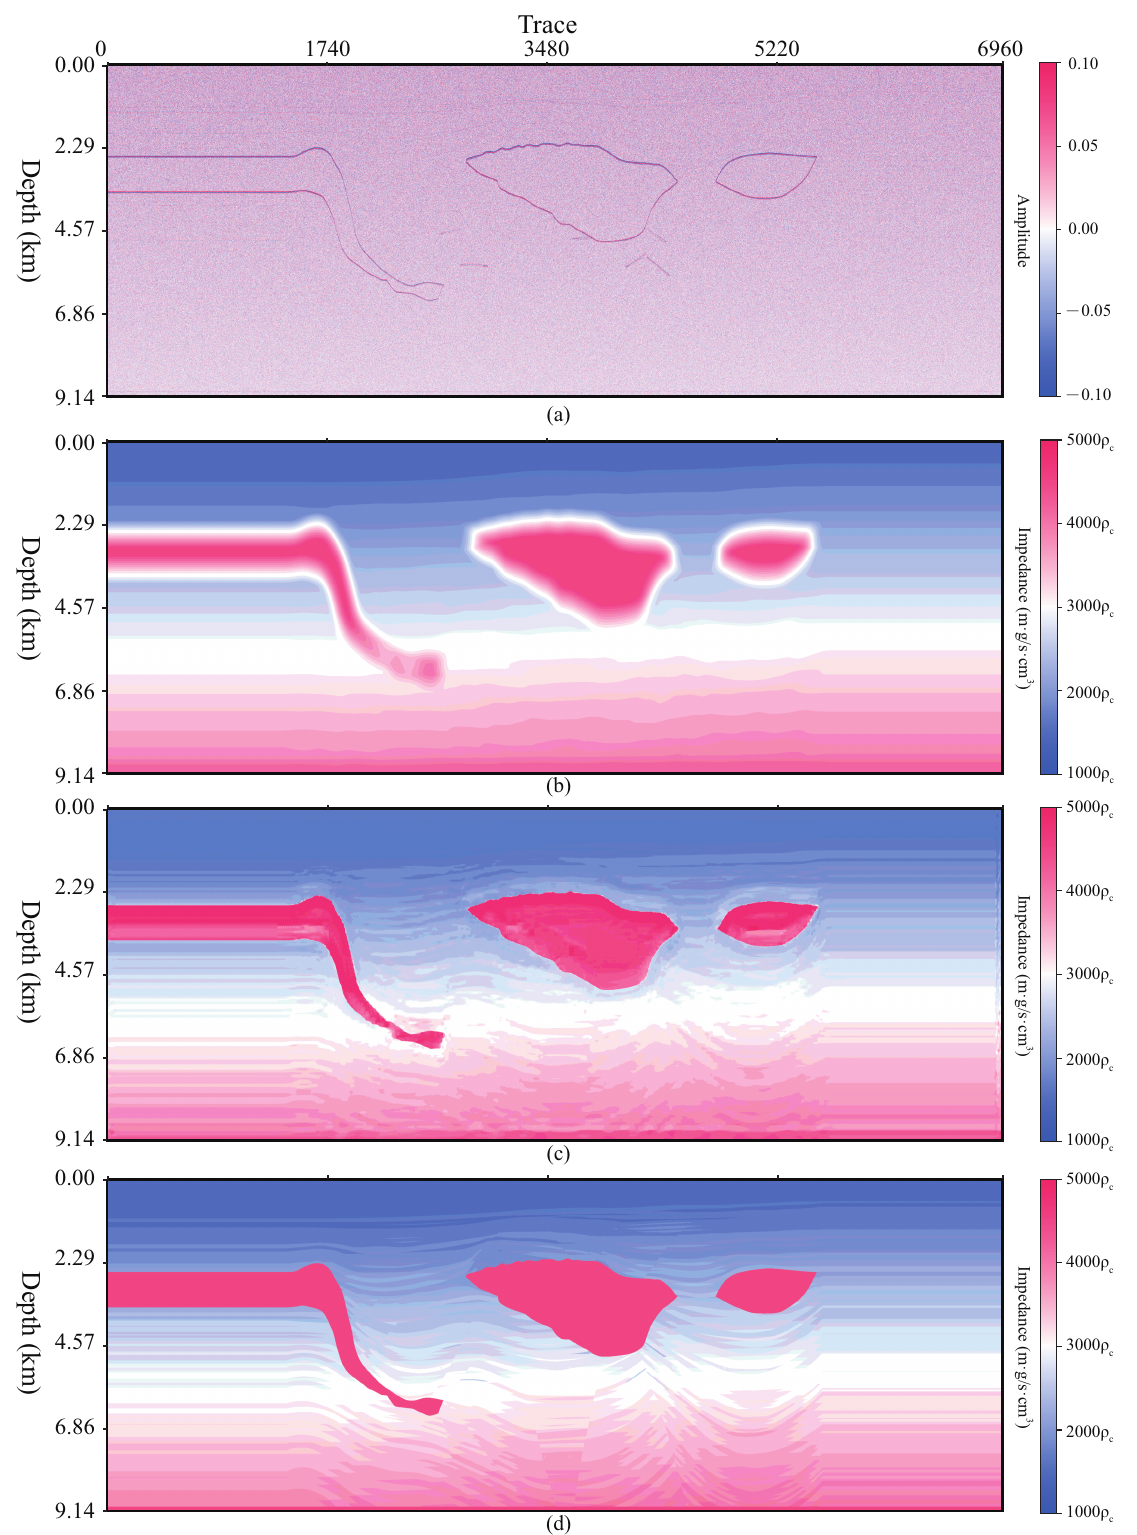
Figure 13. Test result of the Pluto profile, ( a ) M , K = 0.039, SNR = − 5.00 dB, P = 50 ◦ , channel 1 of input data, ( b ) B , channel 2 of input data, ( c ) predicted profile ˆZ , PCC = 0.9678, R 2 = 0.7717, SSIM = 0.8972, PSNR = 22.03 dB. ( d ) label profile Z